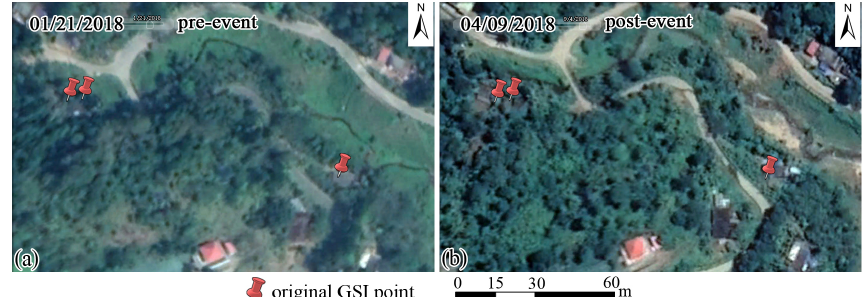
Figure 11. Example of a situation in which the original GSI landslide points were accepted although there were no manifestation of landslide scarps visible in pre- and post-event images from Google Earth. We assumed that landslides were properly marked in the field by the surveyors and that they must have been very small and hidden from view by surrounding vegetation or buildings. Basemap data © Google Earth